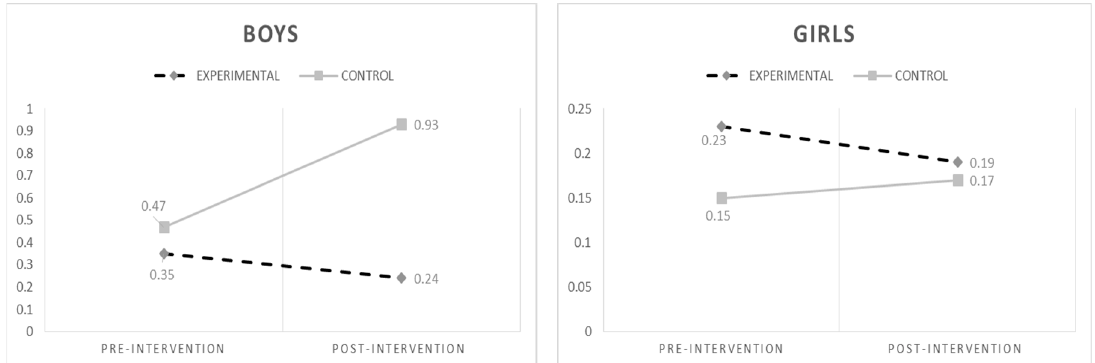
Figure 4. Changes in cyberbullying over time by gender .